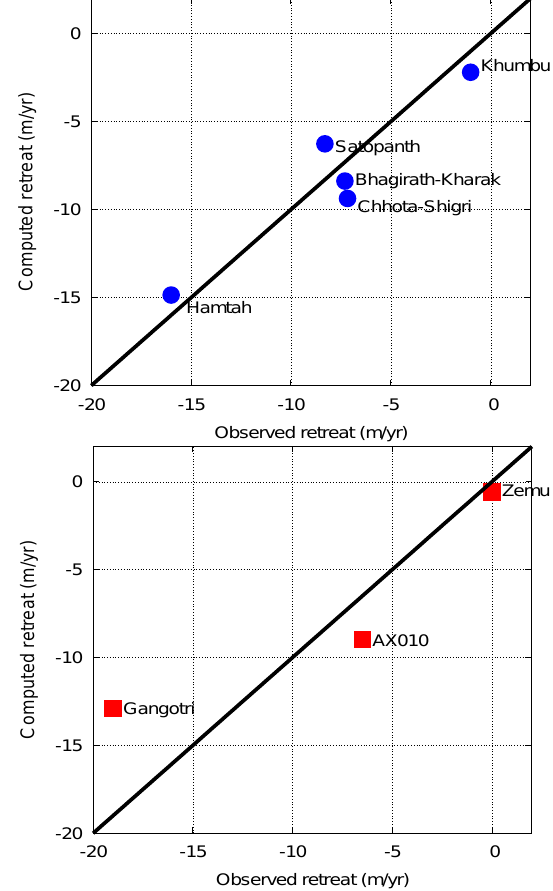
Table 2. Length, slope, F 1 and dL/dh e for the control set of glaciers.